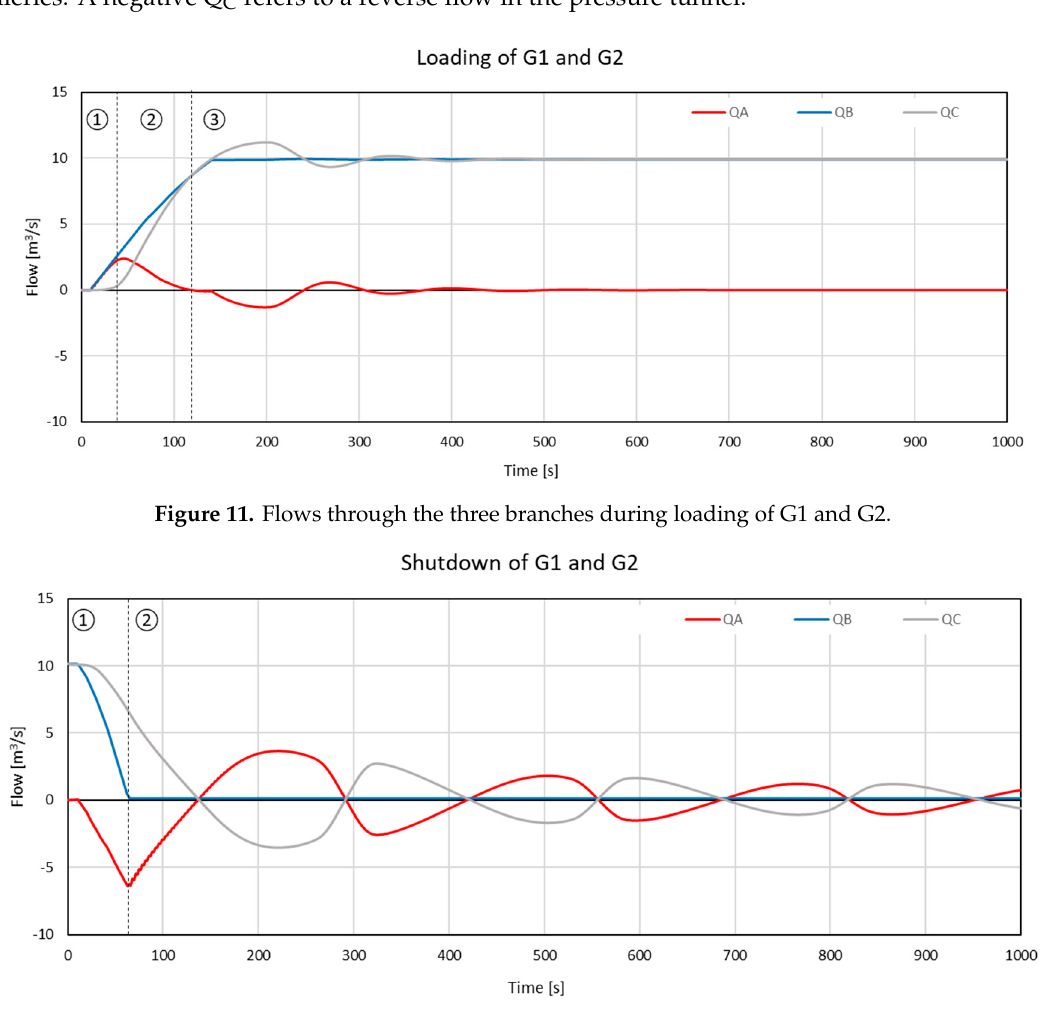
Figure 12. Flows through the three branches during the emergency closure of G1 and G2 .